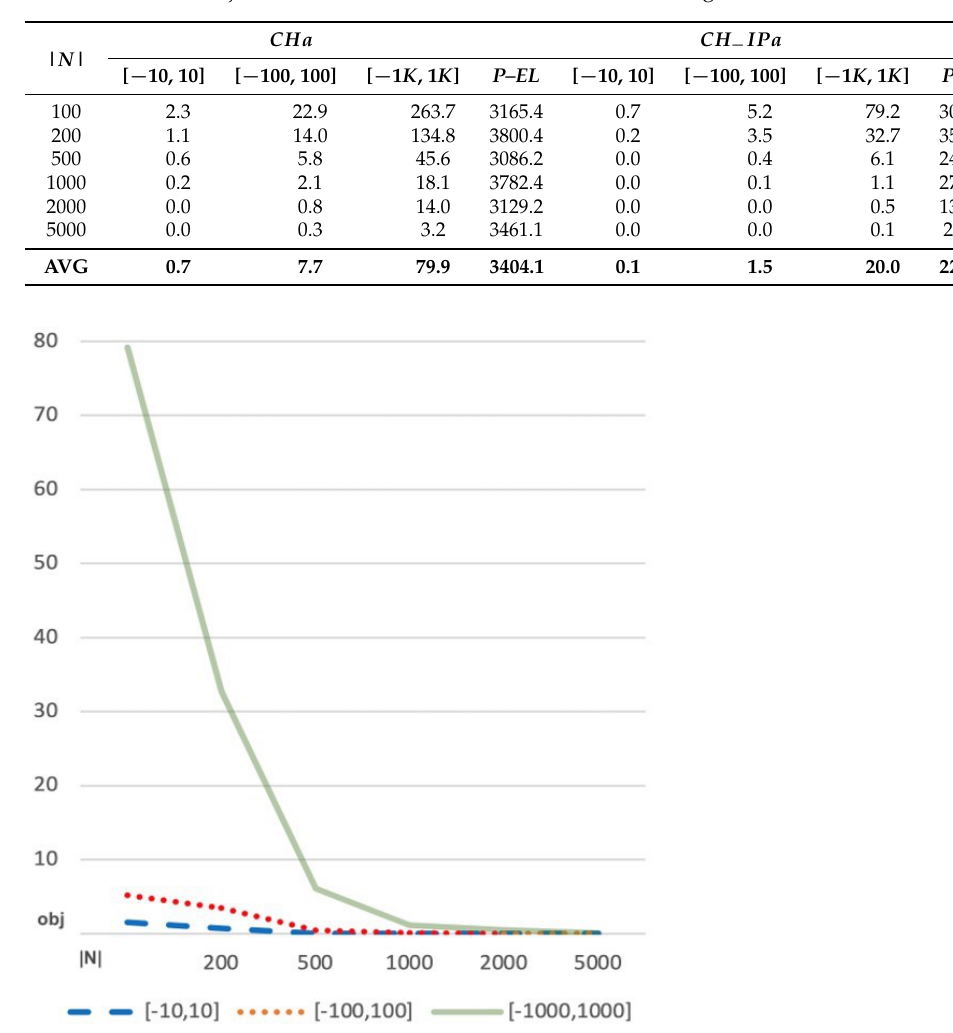
Table 4. Absolute objective function values— CHa and CH − IPa —large instances.